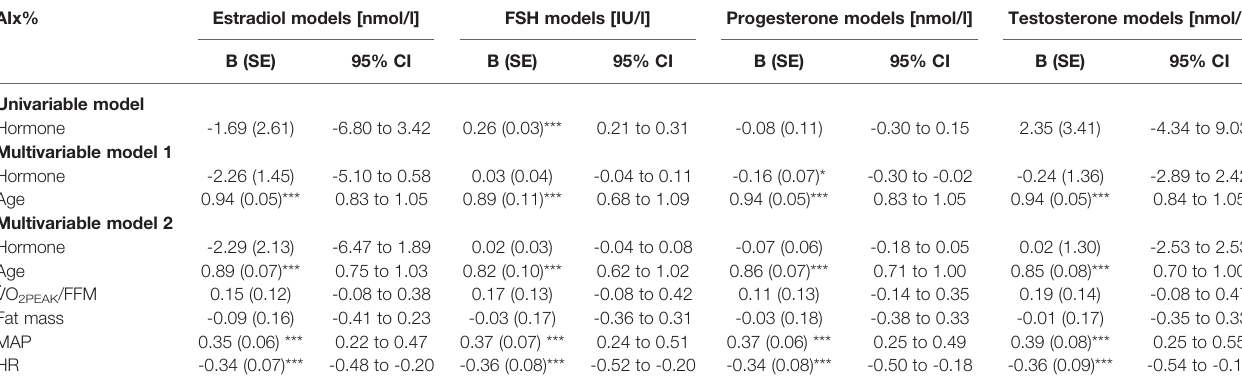
TABLE 4 | Associations of estradiol, follicle-stimulating hormone, progesterone, and testosterone with augmentation index.